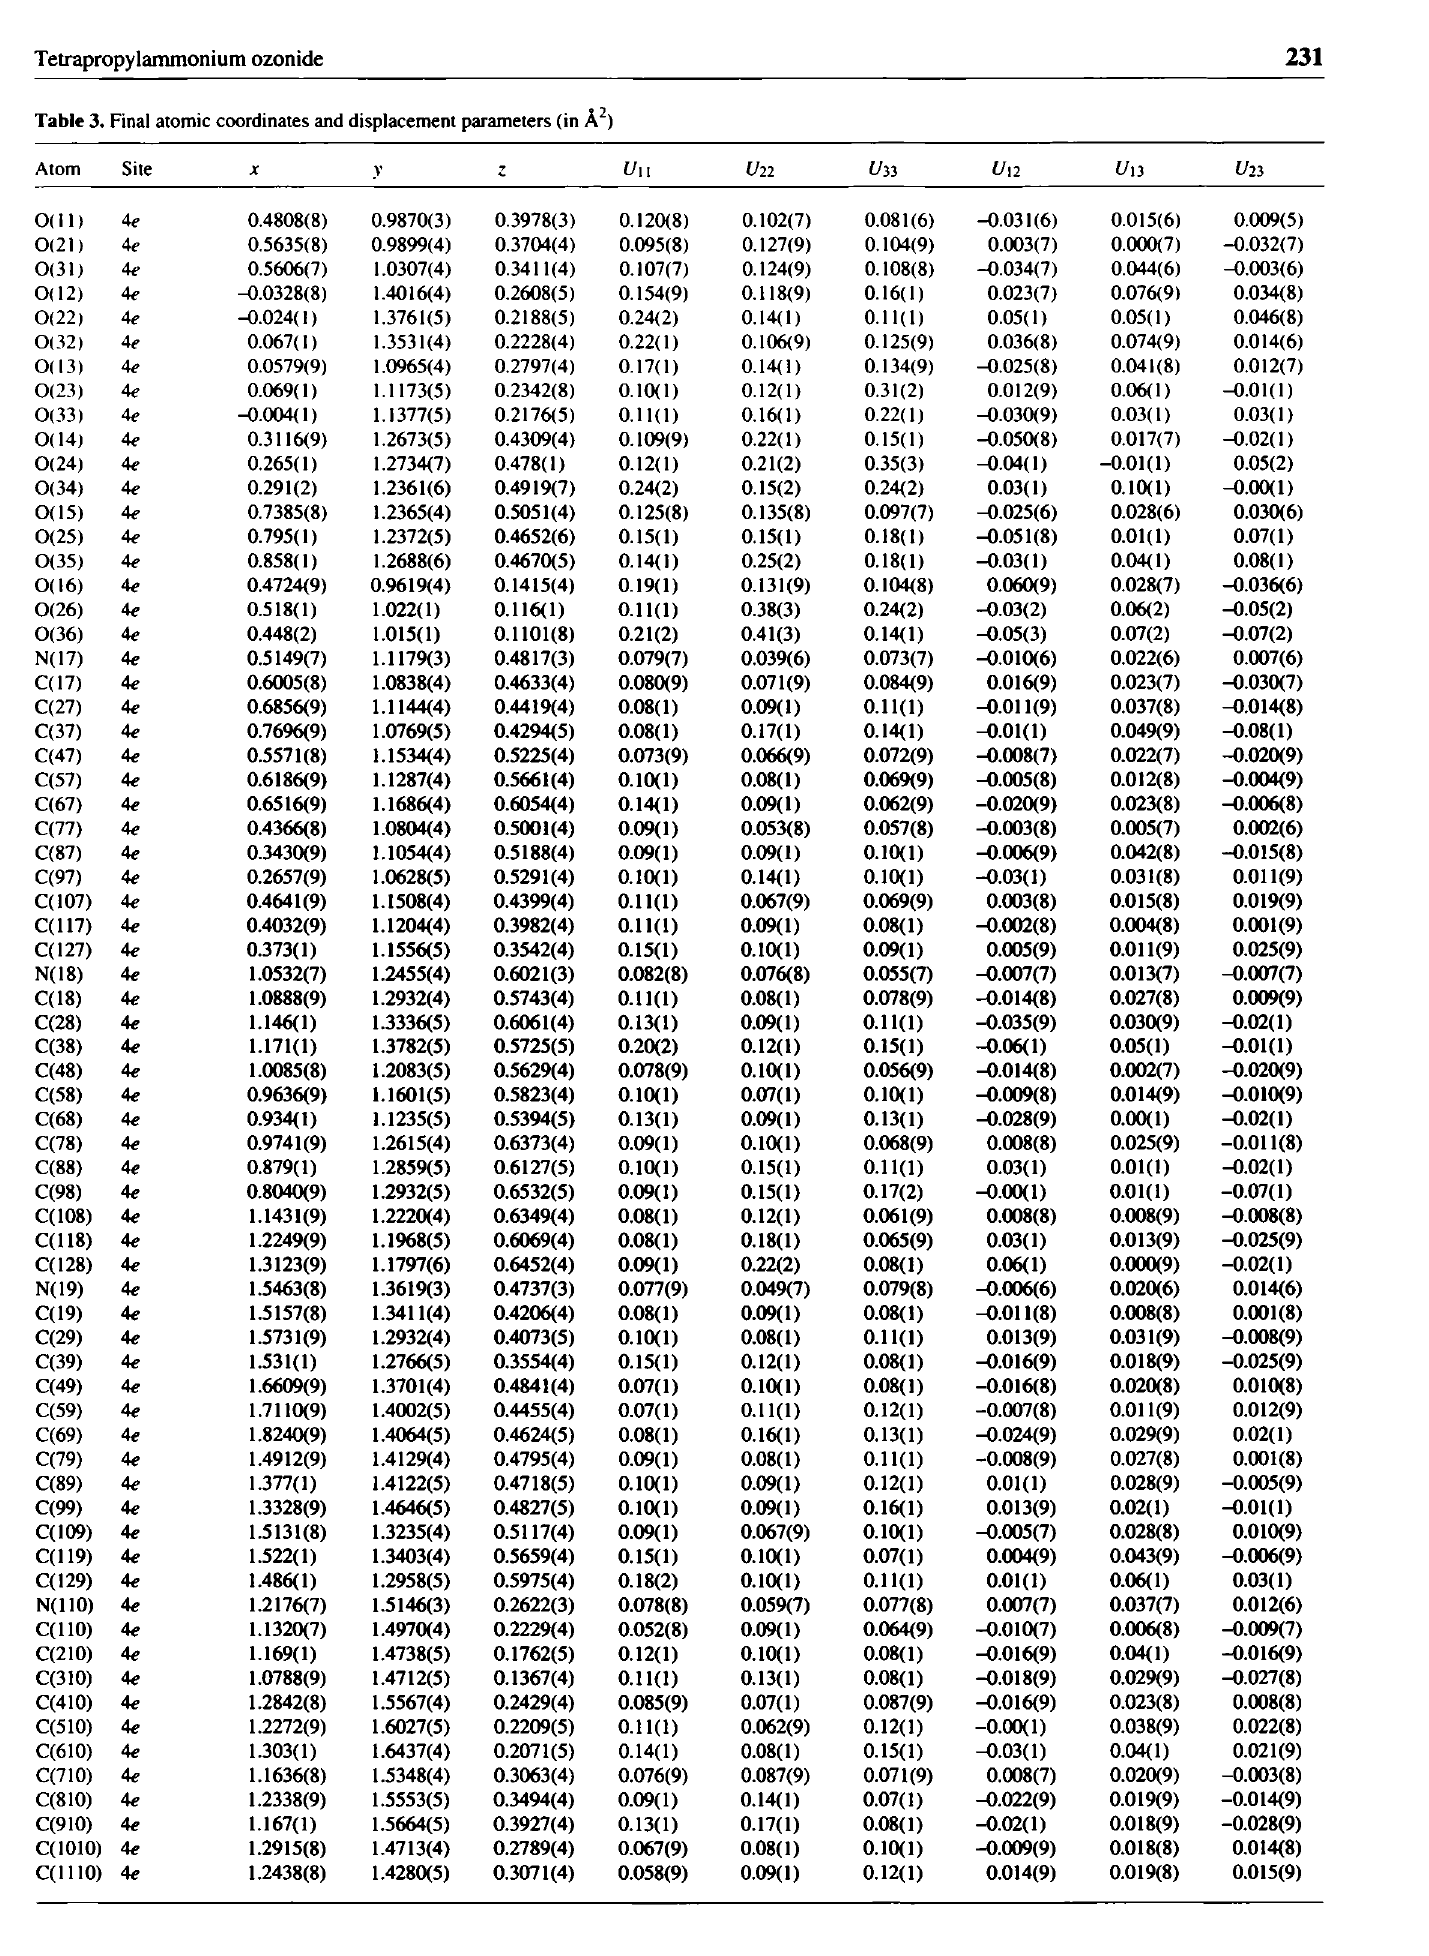
Table 3. Final atomic coordinates and displacement parameters (in Ä 2